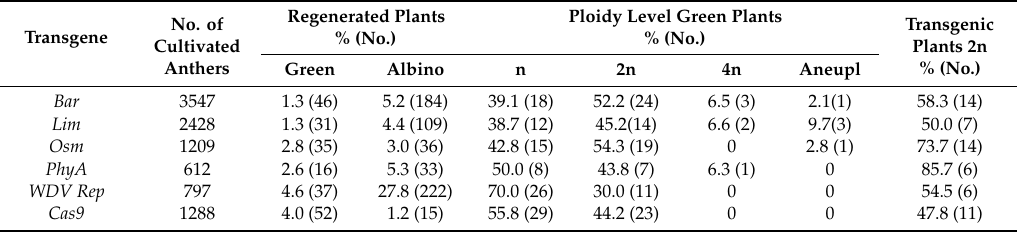
Table 1. Anther cultures from transgenic plants, showing numbers of green and albino plants, and ploidy level.